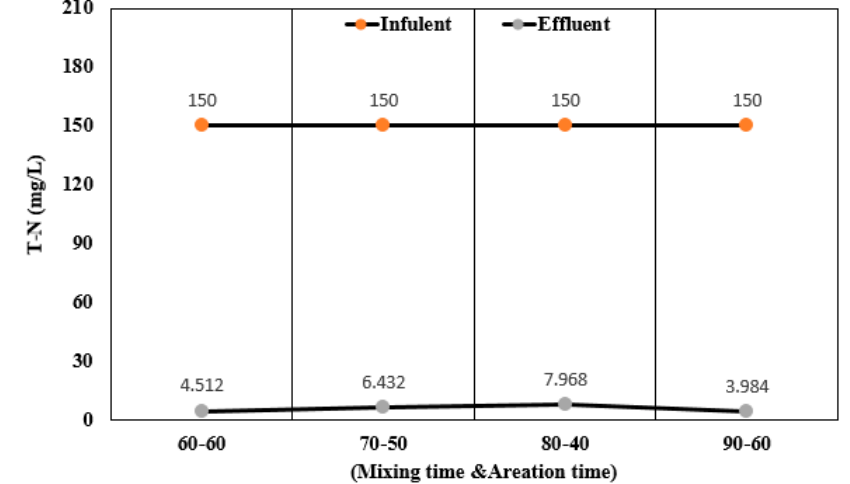
Figure 7. Raw water and treated water changes based on changes in mixing: aeration times (T-N).